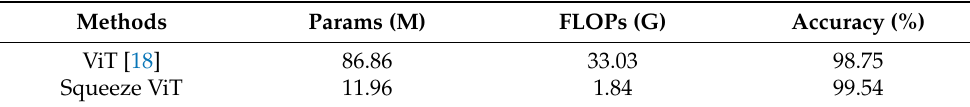
Table 2. Comparison results on the numbers of parameters and computations between pure ViT and the proposed Squeeze ViT method on the CK+